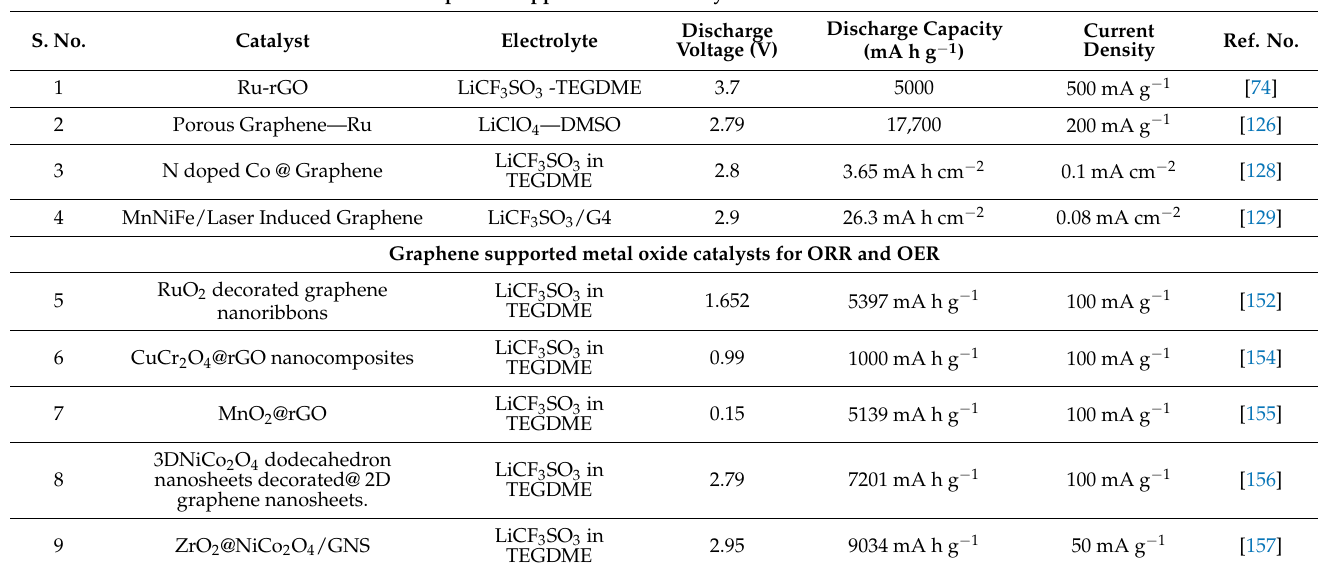
Table 3. Comparison of the cell performances of various metal and metal oxide supported graphene